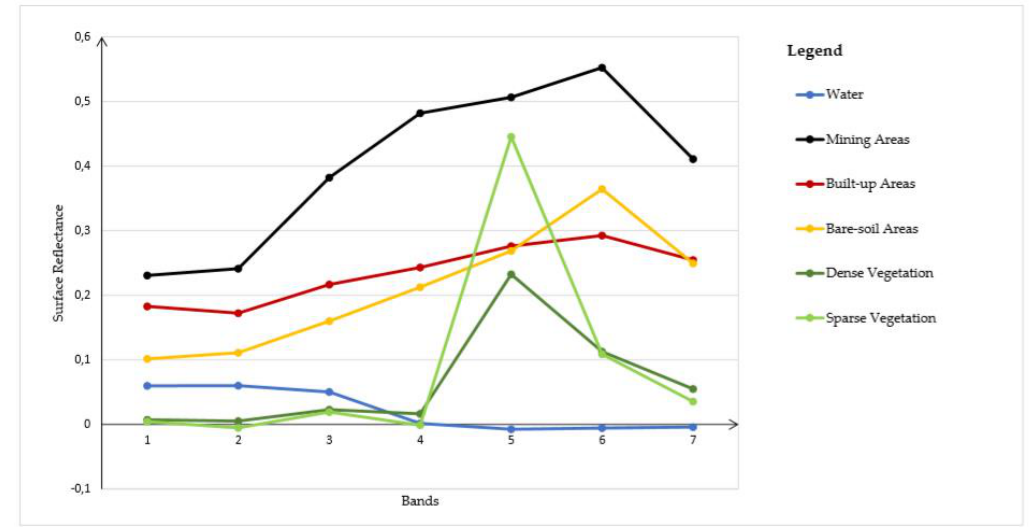
Figure 2. Spectral signature of each class detected in the study area. The x and y axes report the original Landsat bands (Landsat 7 - Enhanced Thematic Mapper Plus (ETM+) and the surface reflectance, respectively, where 1 is band 1 (blue), 2 is band 2 (green), 3 is band 3 (red), 4 is band 4 (near infrared), 5 is band 5 (shortwave infrared 1), 6 is band 6 (thermal infrared), and 7 is band 7 (shortwave infrared 2).